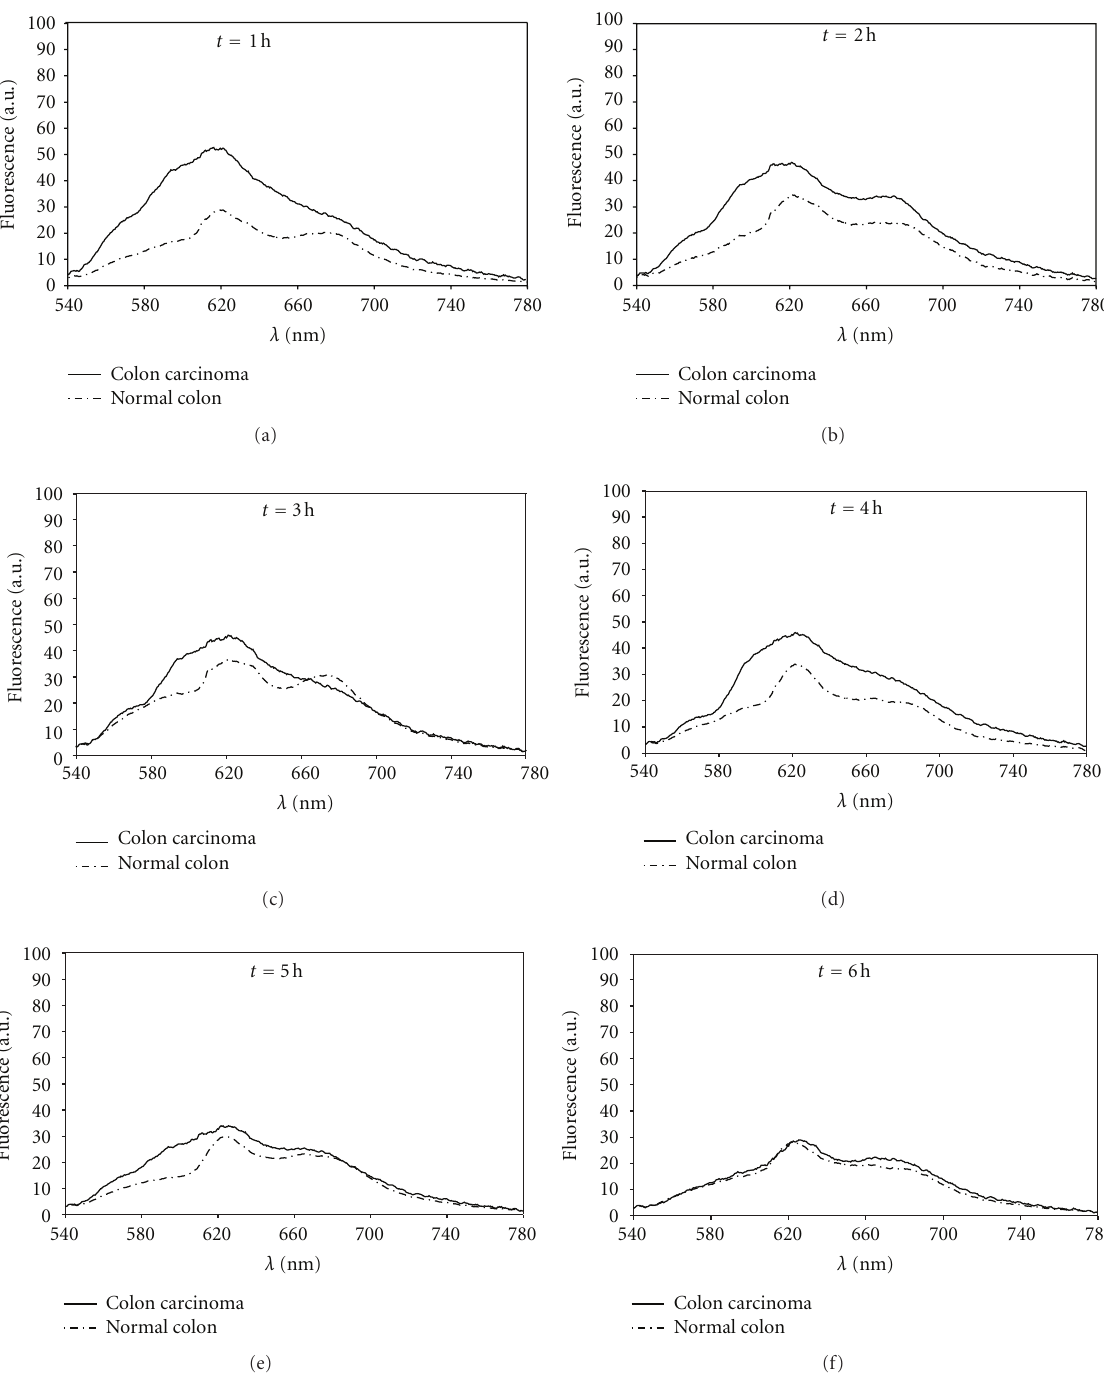
This parameter represents the ability to di ff erentiate tu- mor tissue from normal tissue using fluorescence spectrosco- py information. Selectivity values are shown in Table 3 and Figure